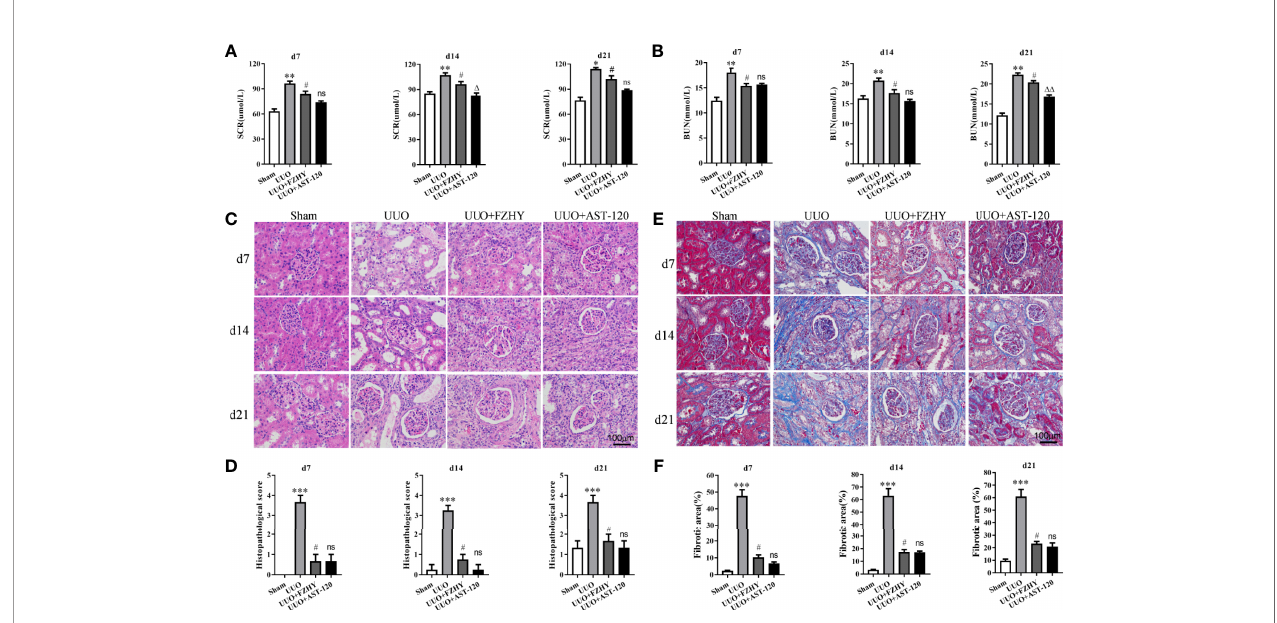
FIGURE 1 | Effect of FuZhengHuaYuJiangZhuTongLuoFang prescription (FZHY) on renal function in unilateral ureteral obstruction (UUO) rats. Levels of the biochemical parameters including serum creatinine (SCR) (A) and blood urea nitrogen (BUN) (B) were detected in the sham, UUO, UUO+FZHY, and UUO+AST-120 groups on days 7, 14, and 21. The renal tissue injury was detected (C) and scored (D) based on histology (HE staining). The renal tissue fi brosis was detected (E) and the relative fi brotic area was analyzed (F) based on Masson ’ s trichrome staining; ×400 magni fi cation on days 7, 14, and 21. * P < 0.05, ** P < 0.01, *** P < 0.001, the UUO group vs. the sham group; # P < 0.05, the UUO+FZHY group vs. the UUO group; D P < 0.05, DD P < 0.01, the UUO+AST-120 group vs. the FZHY- treated group. ns, not signi fi